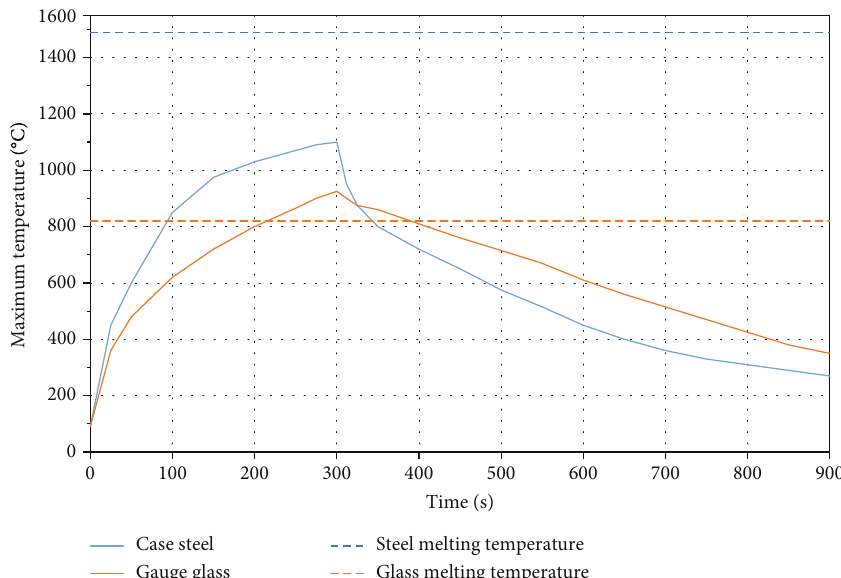
Figure 5: Dependence of maximum temperatures in material on time.